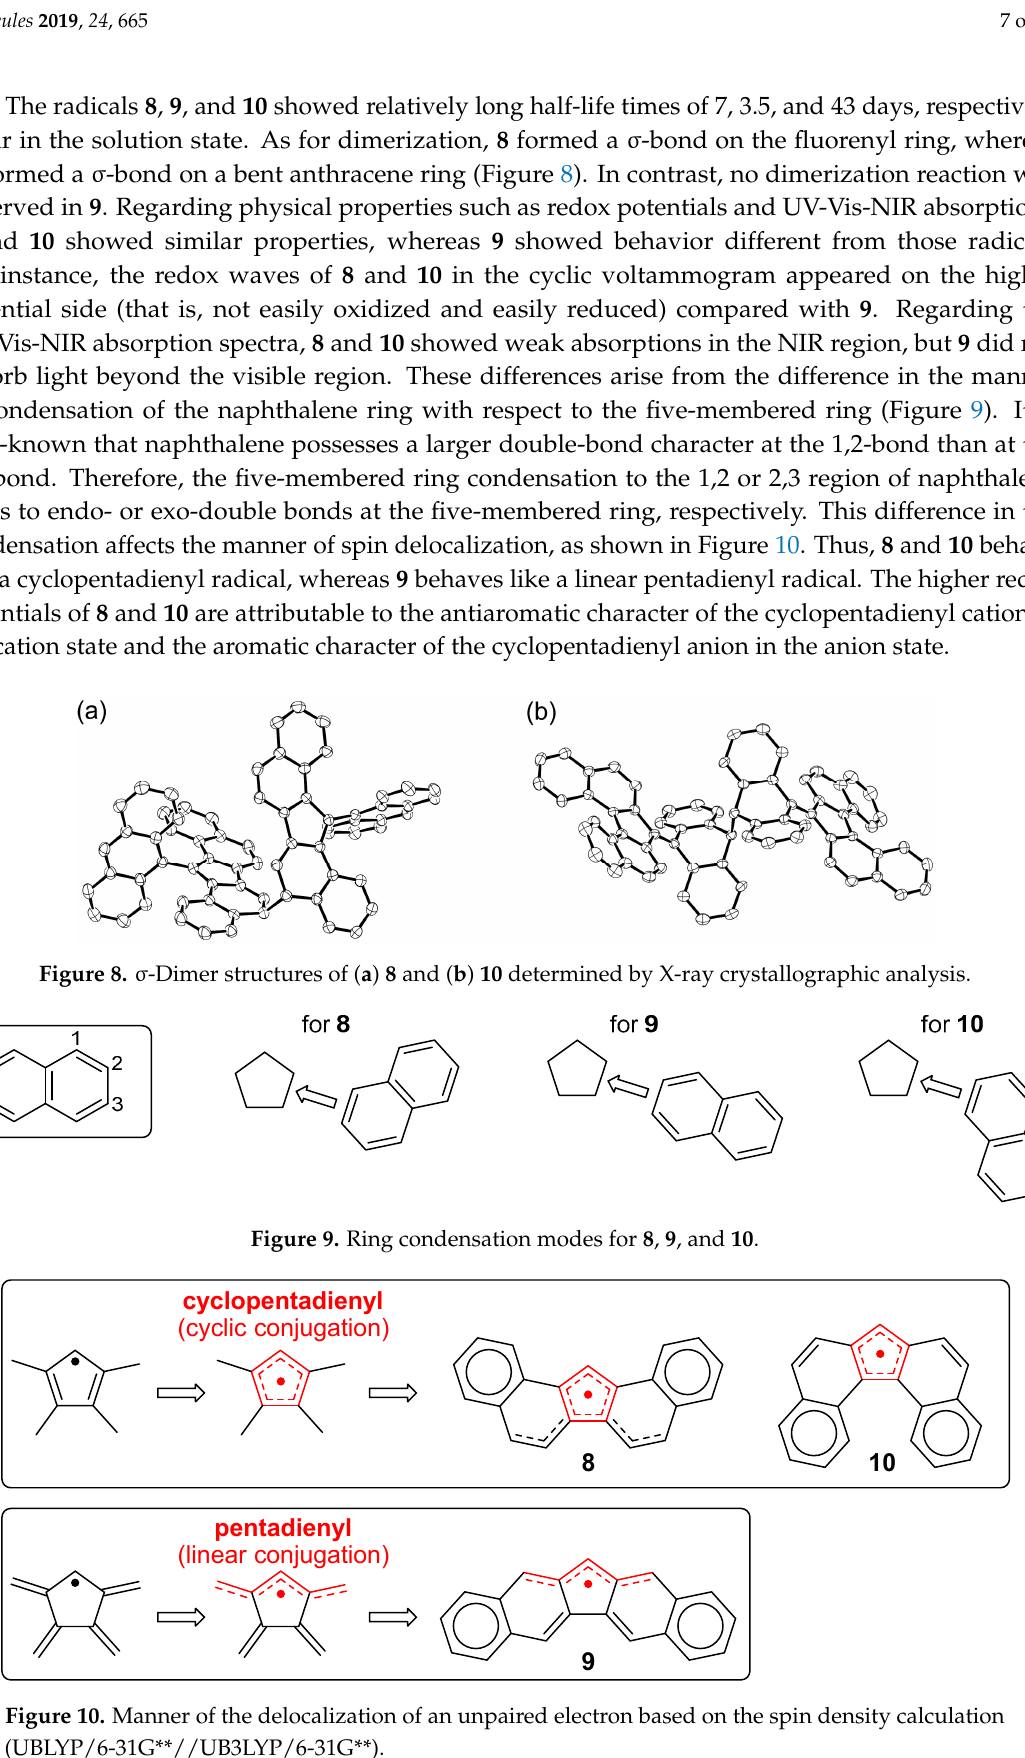
Figure 10. Manner of the delocalization of an unpaired electron based on the spin density calculation (UBLYP/6-31G**//UB3LYP/6-31G**).